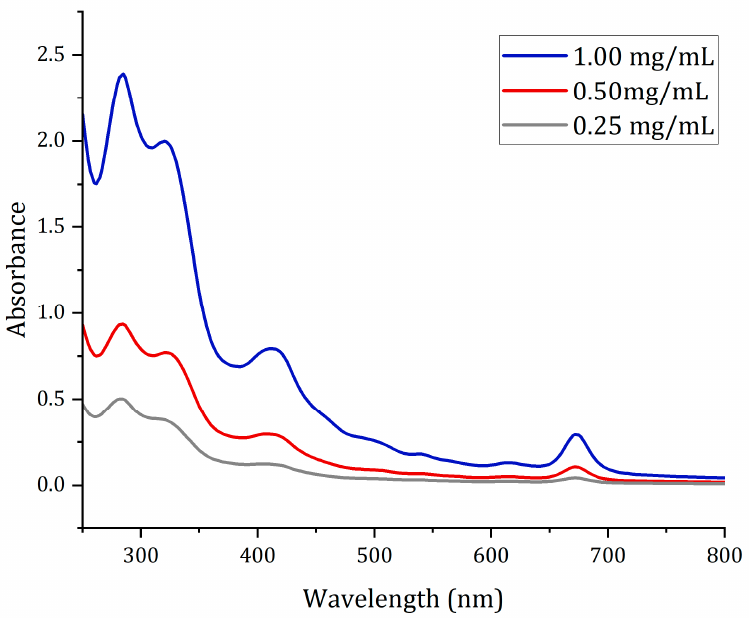
Figure 2. UV/Vis profile of EG-ethanolic sample.